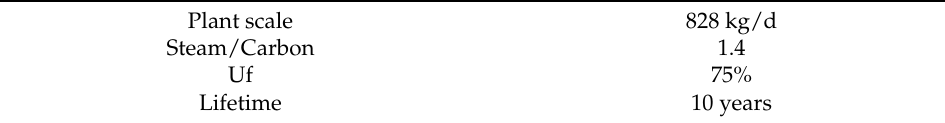
Figure 2. Process diagram of the hydrogen production system. Table 1. The parameters used in the Pt degradation